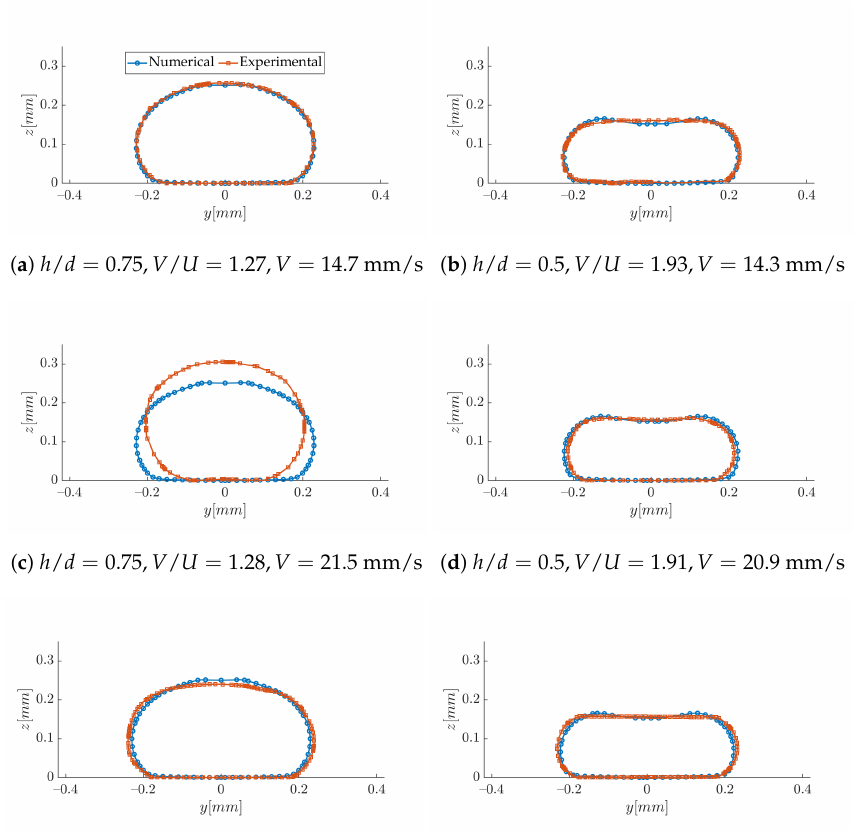
Figure 19. Comparison of strand